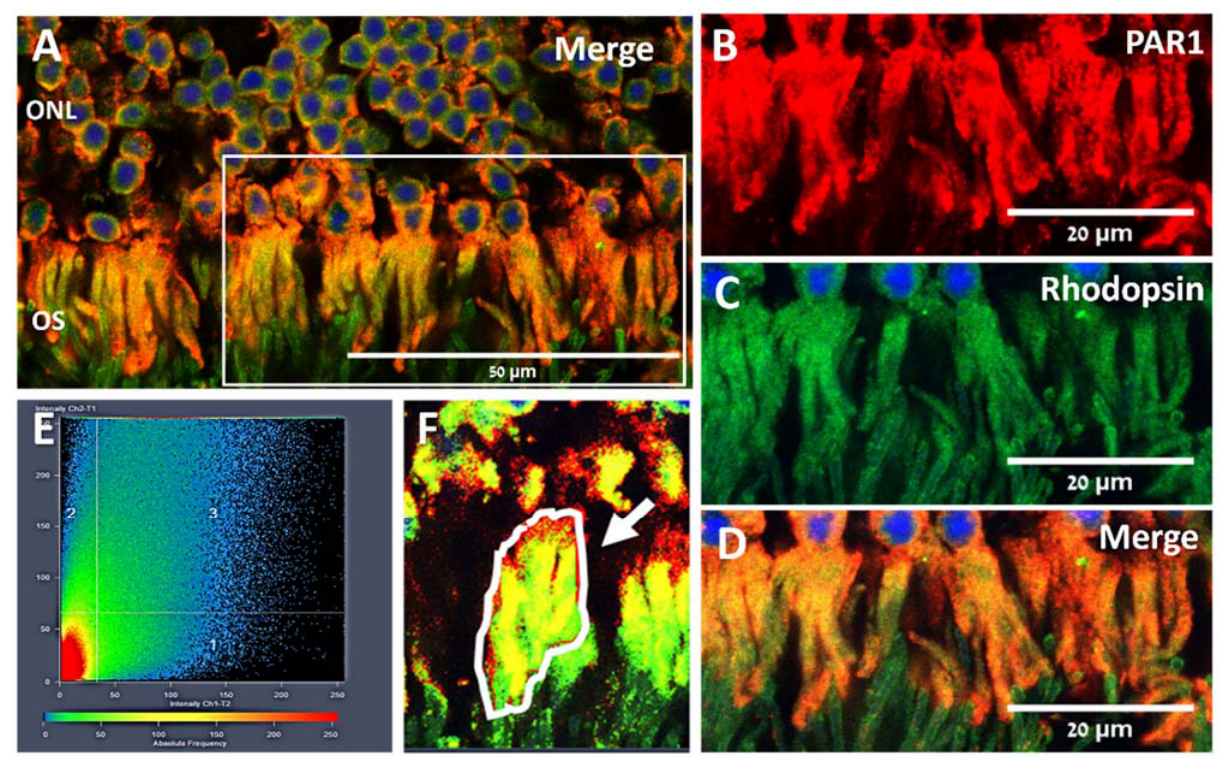
Figure 2. PAR1 co-localization with rhodopsin in mouse retina. A representative image of paraffin retinal sections from C57BL/6J mice co-stained with anti-PAR1 (red) and anti-rhodopsin (green) antibodies. Nuclei were counter-stained with DAPI (blue, A , C , D ). ( B – D ) A larger magnification of the area defined by the white rectangle, showing the red (PAR1, B ), green and blue (rhodopsin and DAPI, C ) channels and the merged image ( D ). Images were obtained with a confocal microscope (LSM700). ONL: outer nuclear layer, OS: (photoreceptor) outer segments. ( E , F ) Co-localization analysis using ZEN software (LSM software ZEN 2012 SP1 Version 8.1, Zeiss, Jena, Germany), calculating Pearson’s correlation coefficient between the red (PAR1) and green (rhodopsin) channels was performed on region of interest (ROI) as representatively indicated by the white arrow ( F ). Co-localization analysis was performed in three areas of retinal sections derived from two mice.